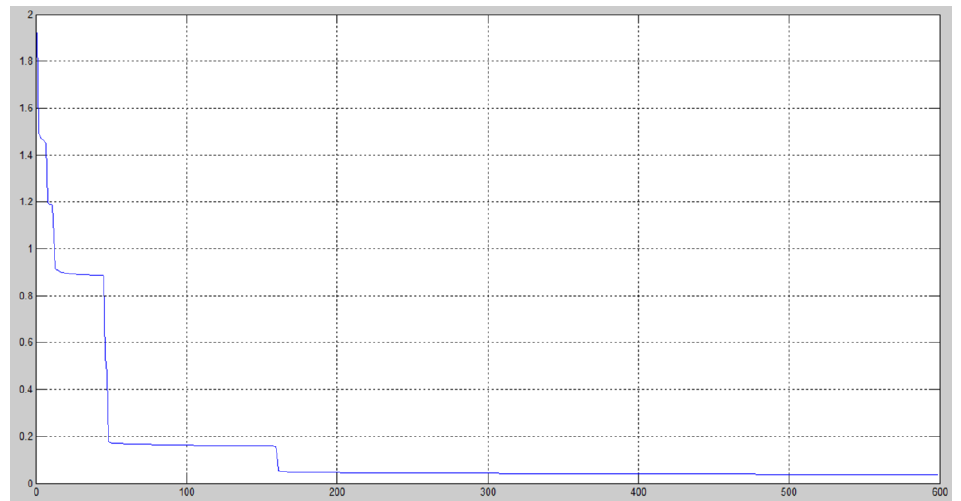
Figure 8. Error change during the training.